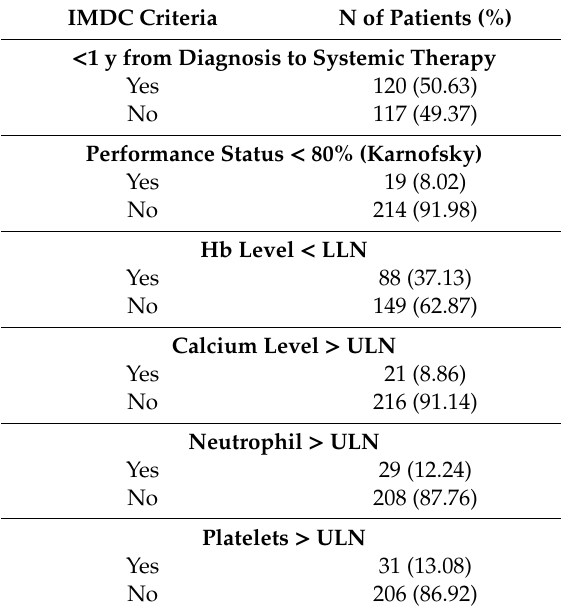
Table 2. Distribution of risk factors according to IMDC criteria in the study populations. LLN = lower limit of normal; ULN = upper limit of